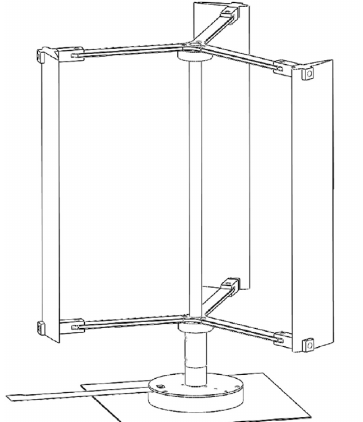
Figure 3. Vertical axis wind turbine tested in Rolin and Porté-Agel